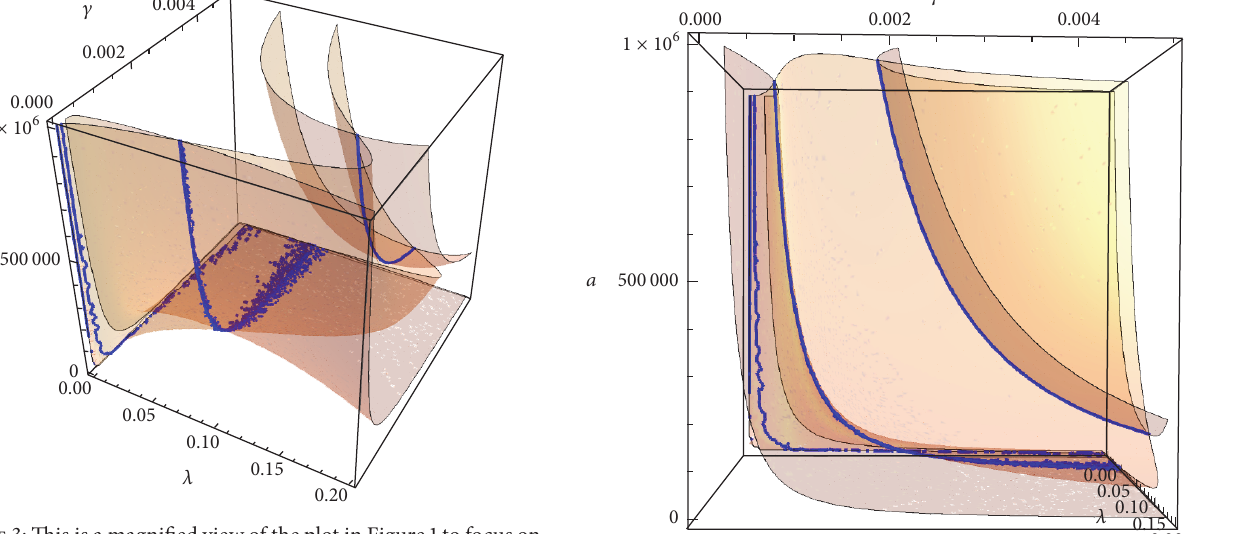
Figure 3: This is a magnified view of the plot in Figure 1 to focus on the curve which gives the solution (along midway of the 𝜆 -axis).